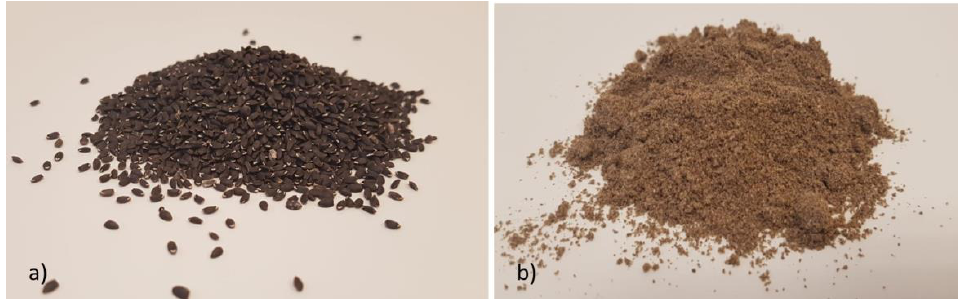
Figure 1. The appearance of seeds ( a ) and bagasse from D. moldavica L. ( b ).